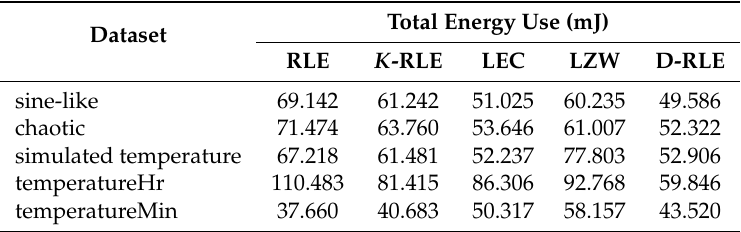
Table 8. Total energy use for the datasets with the same size of 46,080 bits.